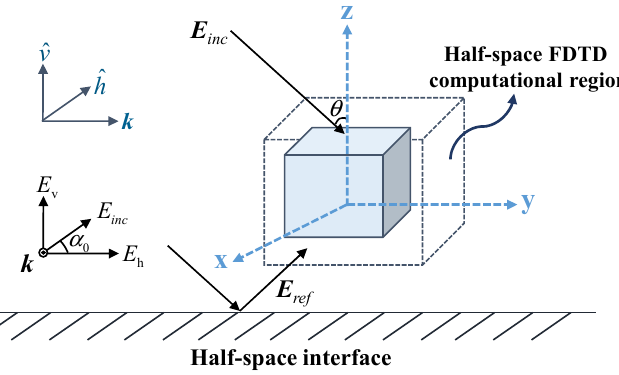
Figure 1. Scattering problem of the target over half-space.